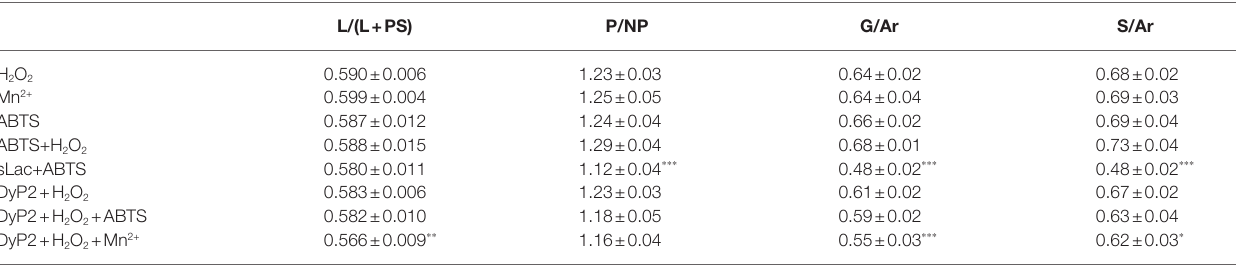
a Lignin modification metrics are indicated and defined in the main text. All reactions contained powdered aspen. Reported values are based on six ToF-SIMS spectra (n = 6). ANOVA analysis with Tukey’s post-test: * p < 0.05; ** p < 0.005; *** p < 0.0005 compared to the no-enzyme controls, including aspen wood powder alone. Refer to Figure 2 for the conditions of aspen, aspen + sLac, and aspen + DyP2.